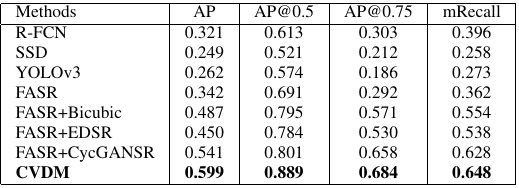
Table 8. Results on Munich DLR dataset